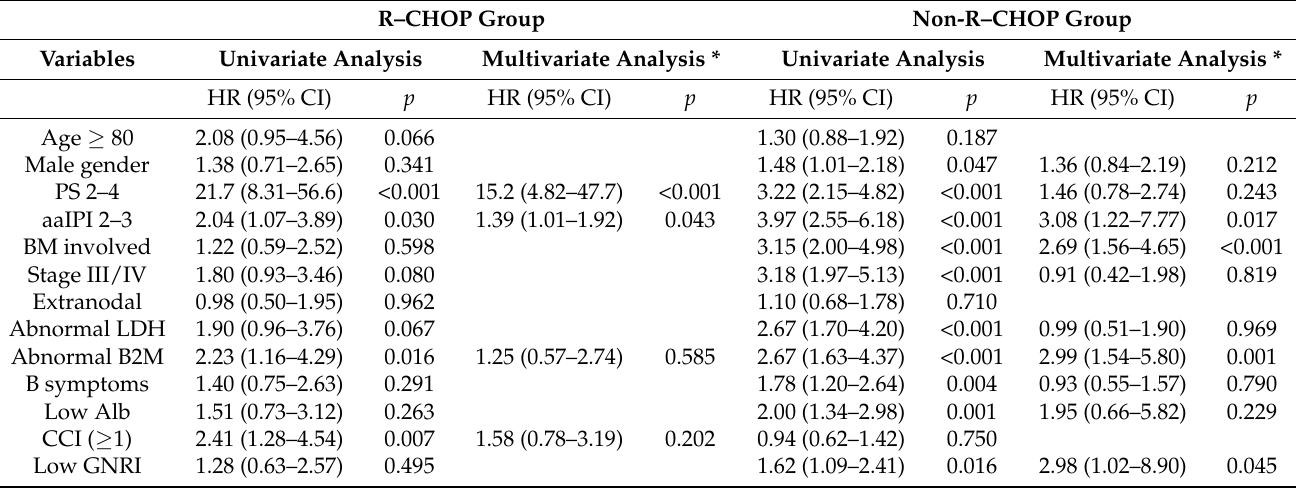
Table 6. The prognostic factors for OS according to univariate and multivariate Cox